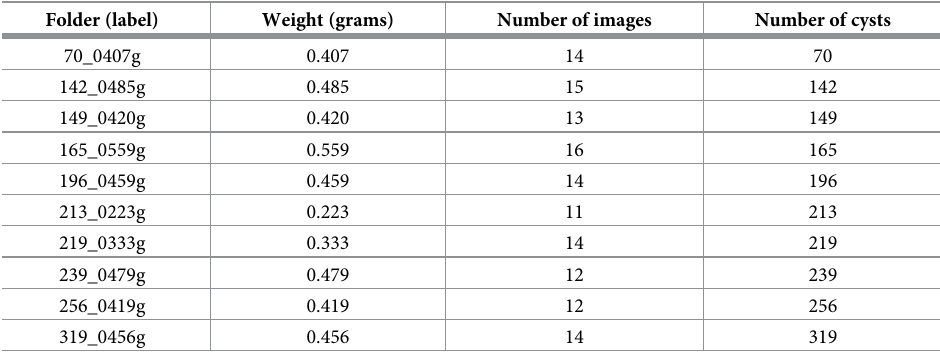
Table 1. The testing set: 10 folders, 135 images, 4.24 grams of substrate, and 1968 cysts. Folder